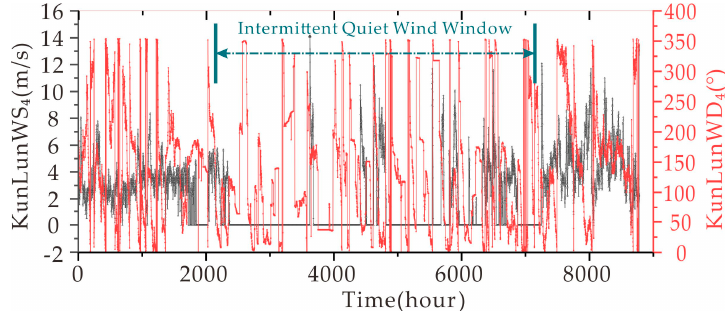
Figure 14. The 4 m wind speed and direction at Kunlun weather station for the whole year of 2020.